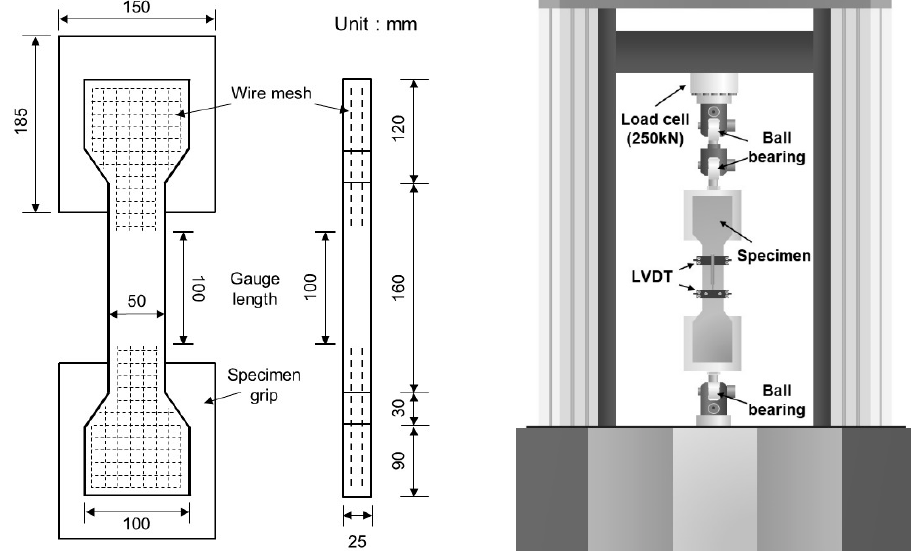
Figure 2. Schematic diagram of direct tensile specimen and static-rate tensile test equipment.